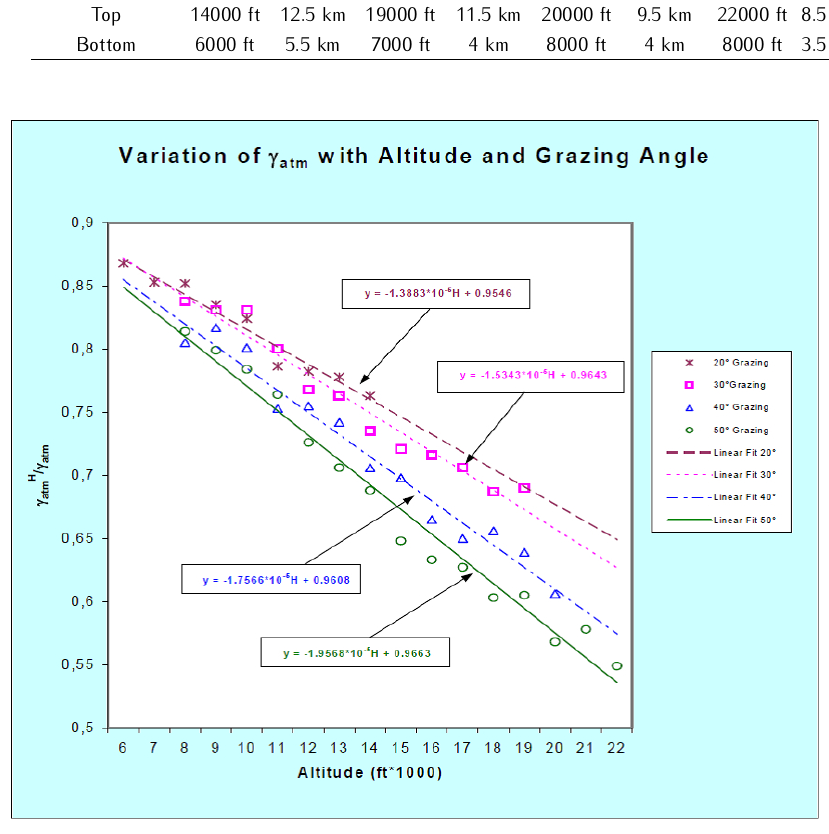
Figure 13. Ratio of the attenuation coefficient to its sea-level value for slant-paths with 20°, 30°, 40° and 50° grazing angles.